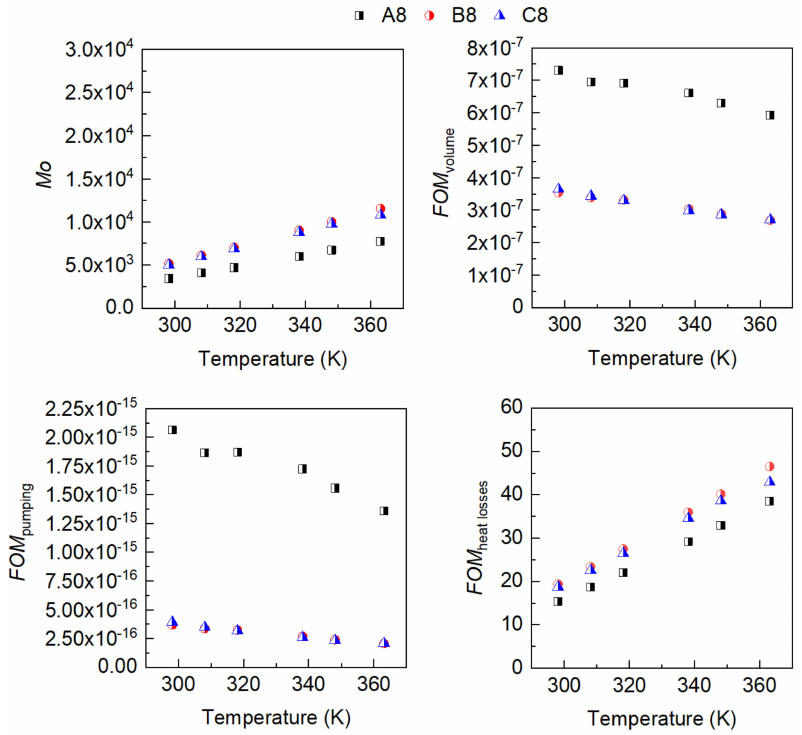
Figure 6. Figures-of-merit (FOM s ) of the aged ATFs (A8, B8, C8).